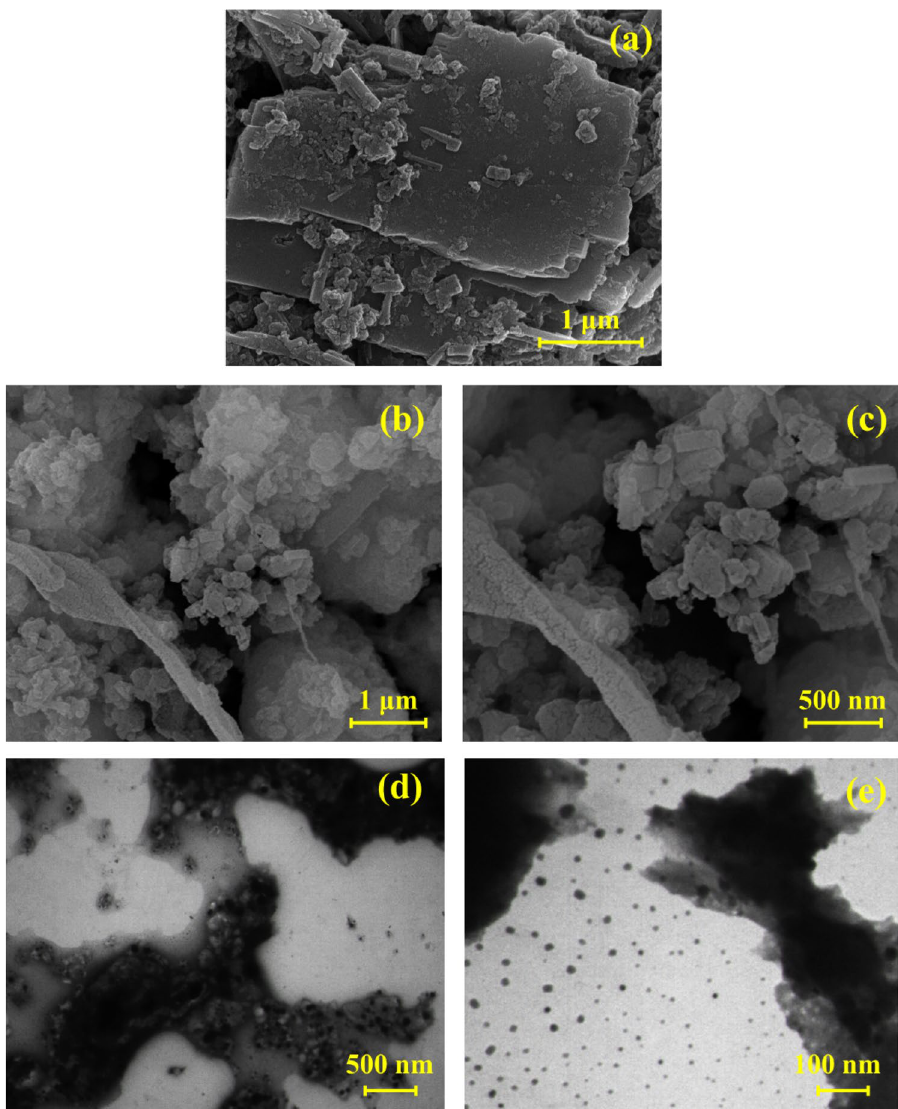
Figure 4. FE-SEM images of ( a ) CN, ( b , c ) CN-Pr-β-CD/Cu(II) and, ( d , e ) TEM images of